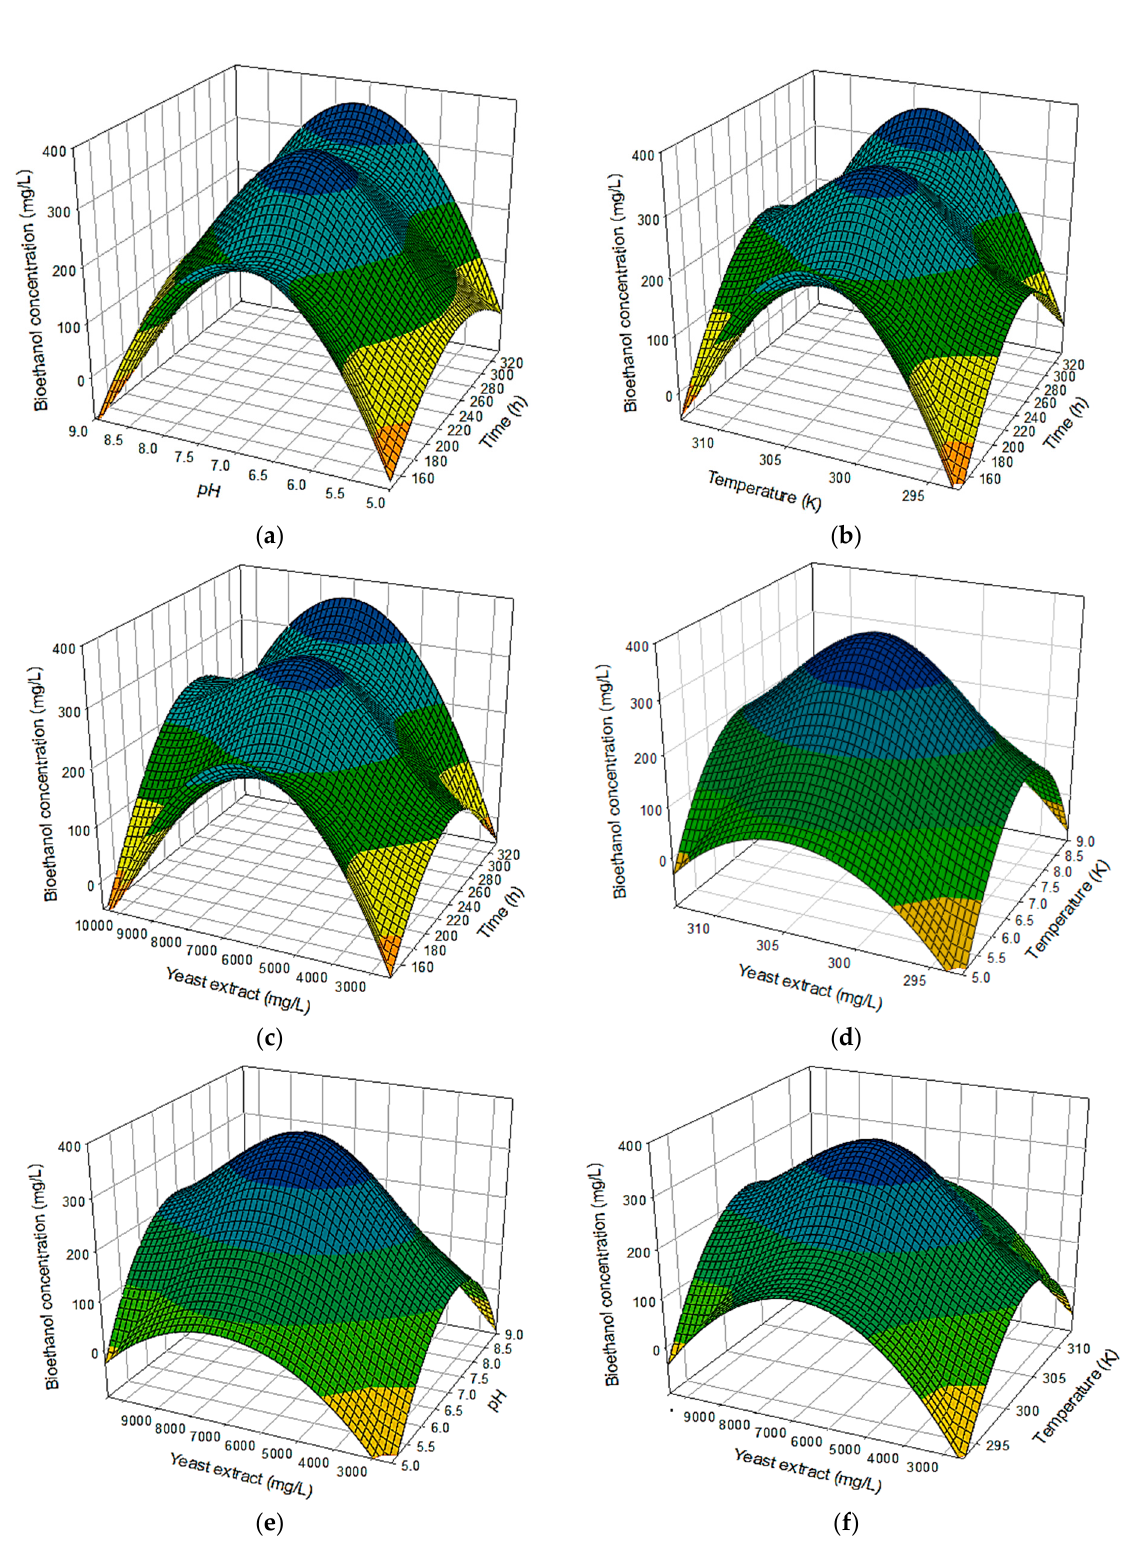
Figure 1. Effect of factor interaction between ( a ) pH and time, ( b ) temperature and time, ( c ) yeast extract and time, ( d ) yeast extract and temperature, ( e ) yeast extract and pH, ( f ) yeast extract and pH on the bioethanol concentration.